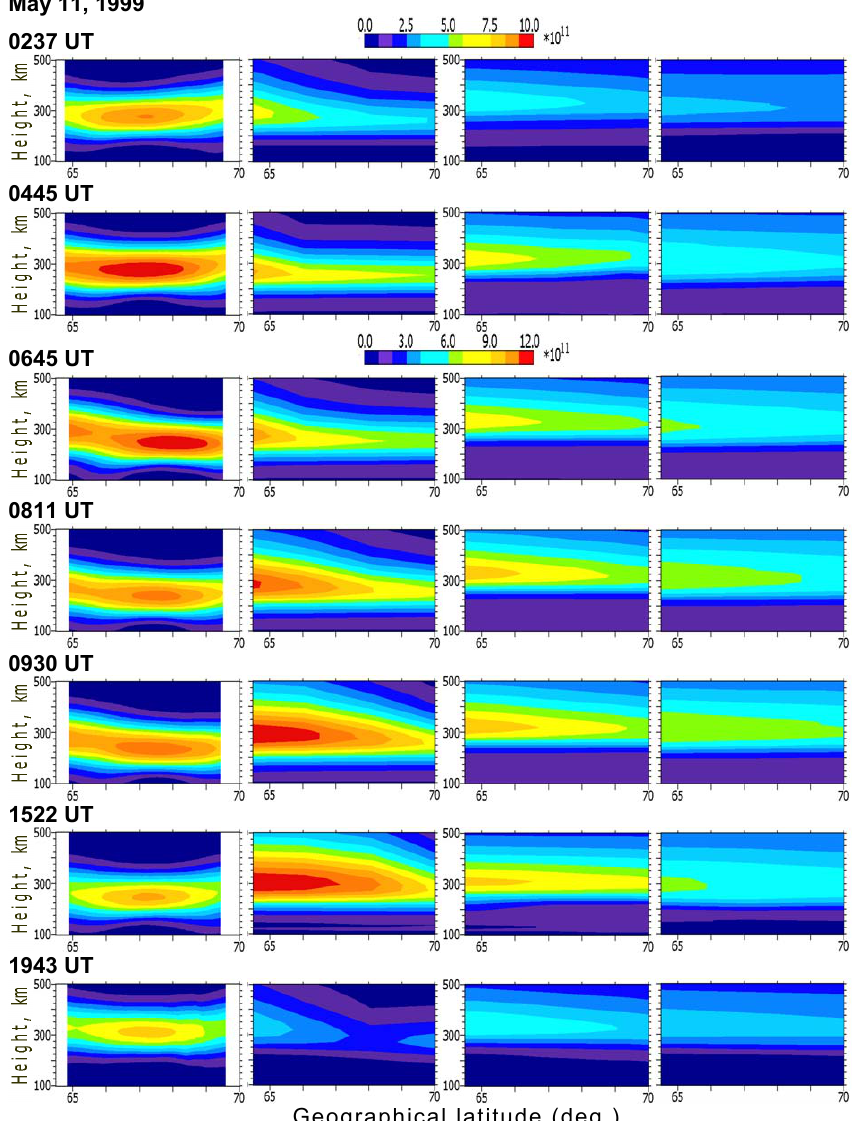
Fig. 8. Same as Fig. 3, on 11 May 1999.